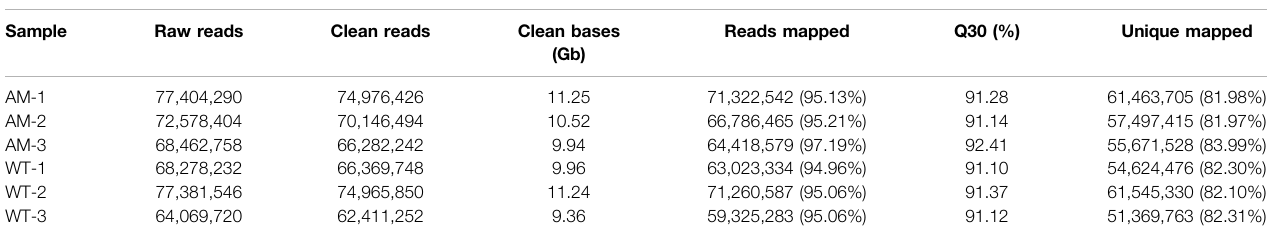
TABLE 1 | The sequencing quality evaluation of